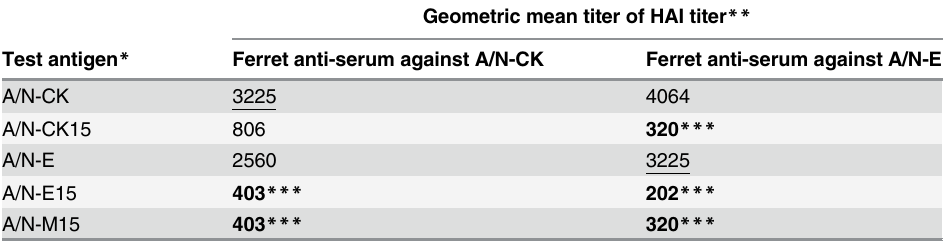
Table 4. HAI assay of A/N with ferret